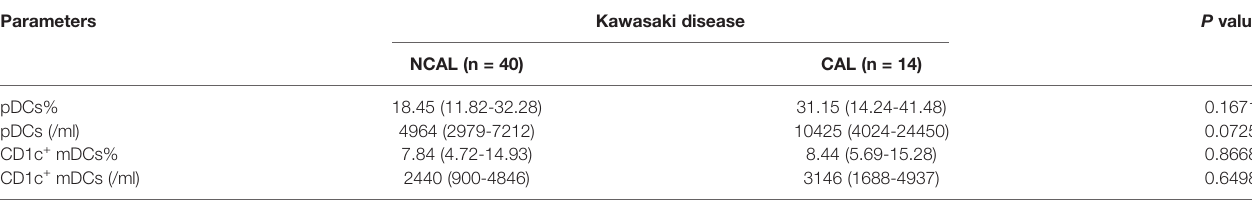
TABLE 3 | Percentage and number of DC subsets between KD patients with and without CAL.